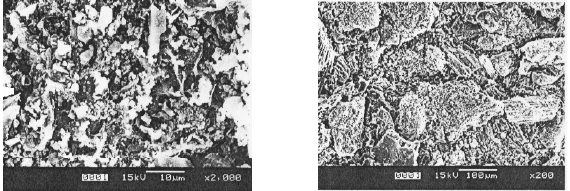
Figure 1. SEM analysis of ZnCl